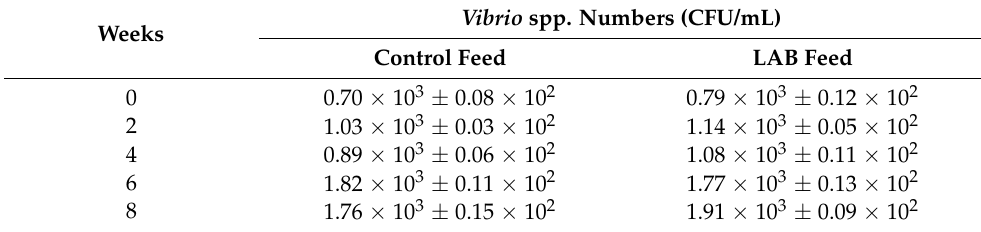
Table 4. The Vibrio spp. numbers in environmental seawater.